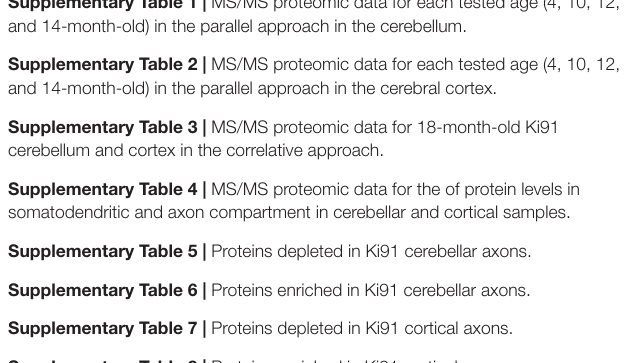
Supplementary Table 5 | Proteins depleted in Ki91 cerebellar axons. Supplementary Table 6 | Proteins enriched in Ki91 cerebellar axons. Supplementary Table 7 | Proteins depleted in Ki91 cortical axons. Supplementary Table 8 | Proteins enriched in Ki91 cortical